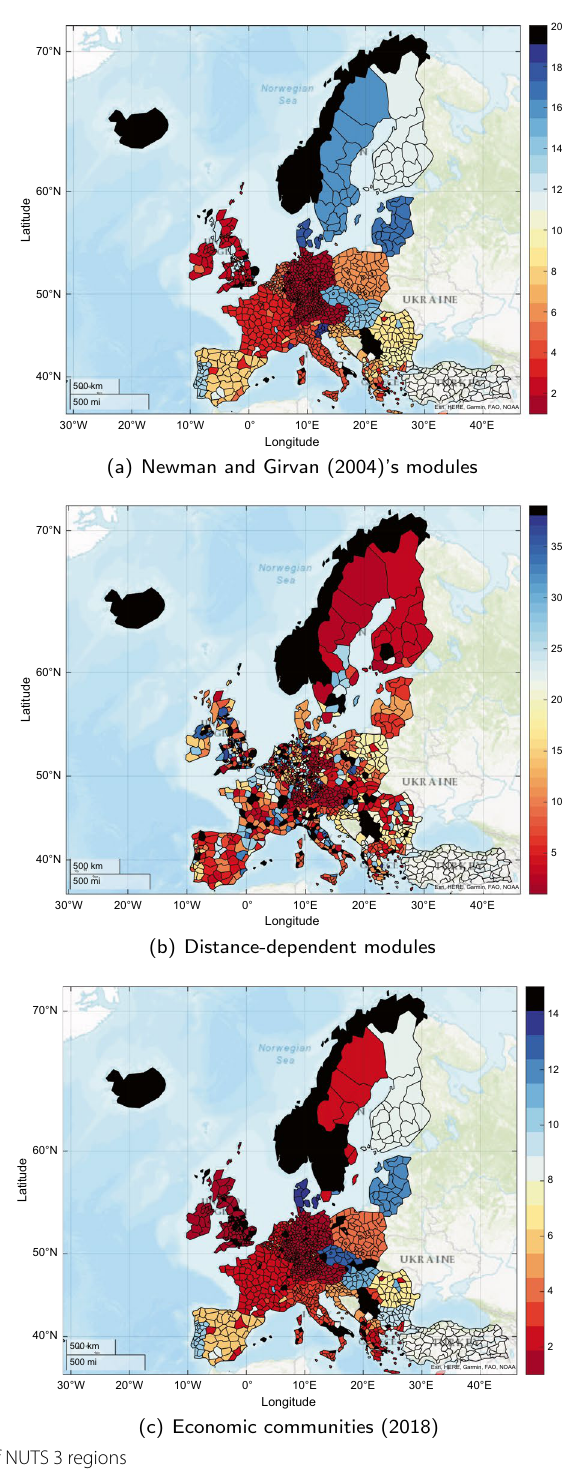
Fig. 6 Modules of NUTS 3